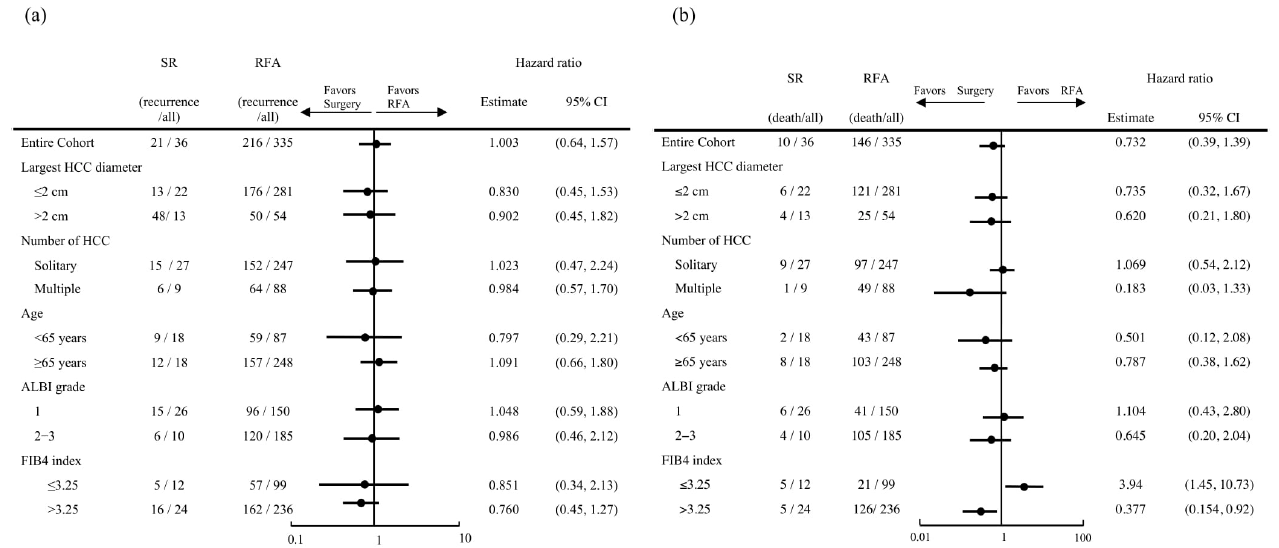
Figure 1. Recurrence-free and overall survival in patients who underwent surgical resection (SR) or radiofrequency ablation (RFA). ( a ) Median recurrence-free survival (mRFS) in the SR and RFA groups was 28.1 (95% CI: 23.4–50.0) and 22.1 (95% CI: 19.3–26.2) months, respectively ( p = 0.34). ( b ) Median overall survival (mOS) in the SR and RFA groups was 78.9 (95% CI: 49.3—not applicable) and 71.2 (95% CI: 61.8–84.7) months, respectively ( p = 0.337).